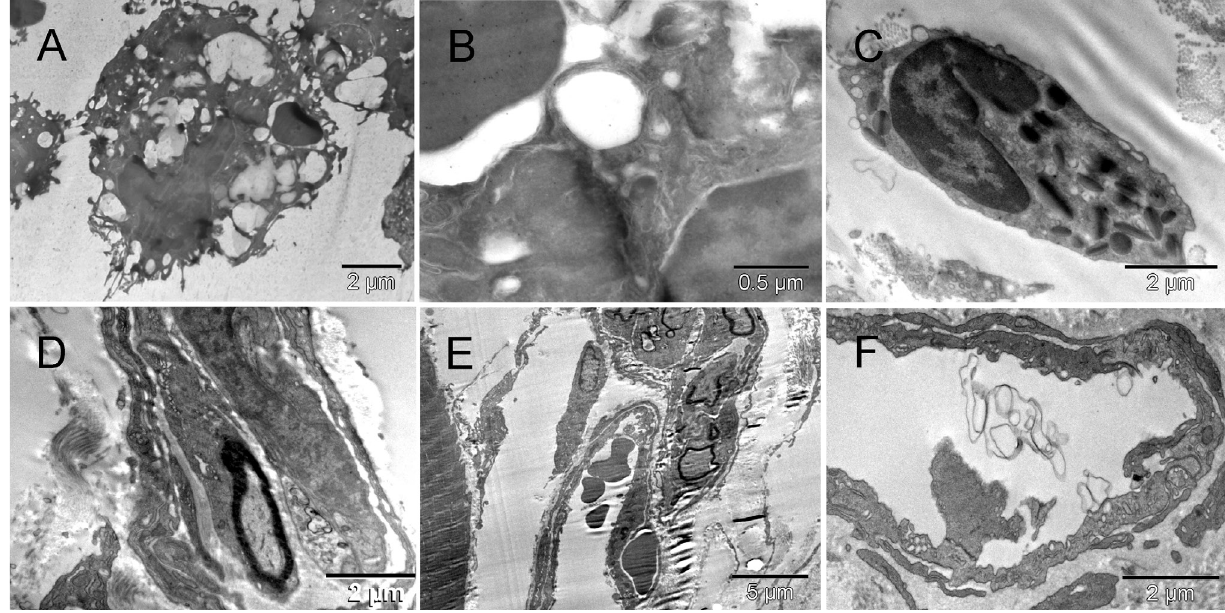
Figure 15. Rare findings. [ A & B ]: Erythrosome labeled with ubiquitin-detecting antibody, internalized by non-labeled macrophage (Mouse 5). [ C ]: Eosinophil (Mouse 3). [ D ]: Myelinated nerve fiber engulfed by Schwann cell (Mouse 2). [ E ]: Forming vessel located between muscle and nerves (Mouse 2). [ F ]: Empty vein or lymphatic vessel with an internal valve (Mouse